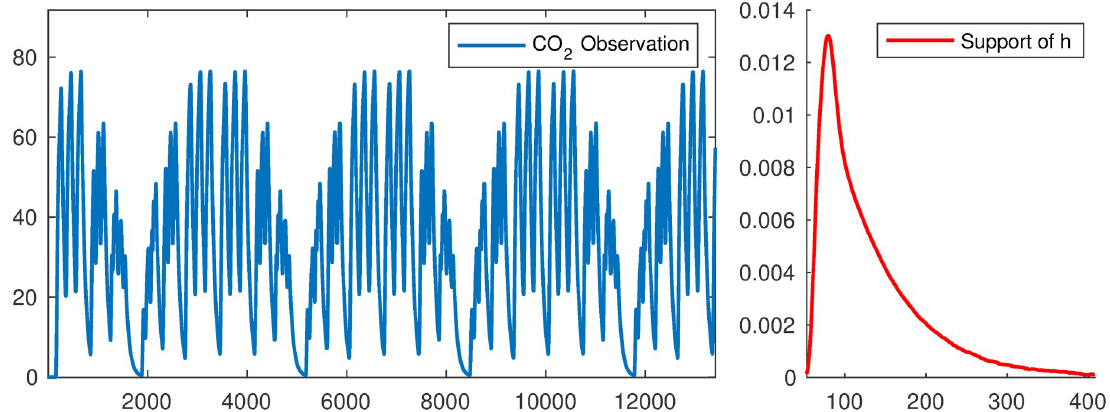
Fig 11. Experimental set-up for linear case study. CO 2 observations from manipulated input CO 2 signals to the empty chamber (left) and experimental impulse response function